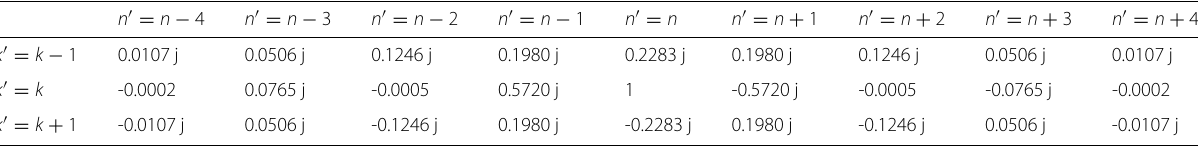
Table 1 Transmultiplexer response γ k with K = 4 (numerical values truncated to 4